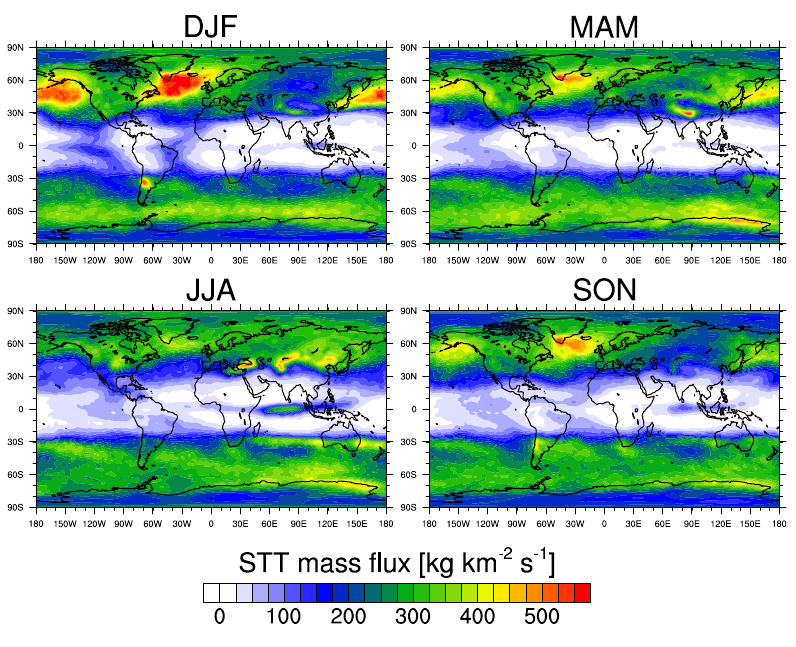
Fig. 2. Seasonally averaged STT mass flux for 1979–2011 (DJF: December, January, February; MAM: March, April, May; JJA: June, July, August; SON: September, October, November).